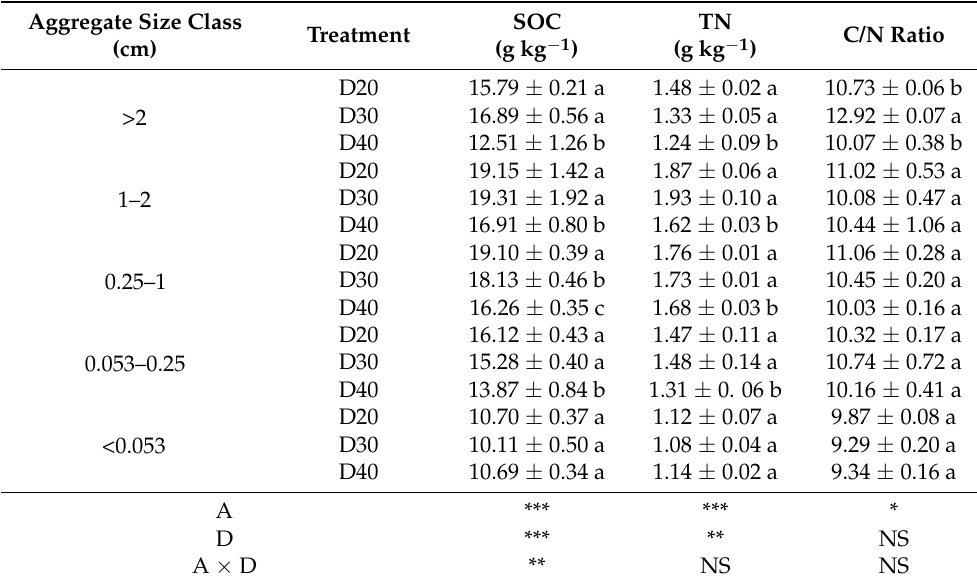
Figure 2. Soil aggregate size distribution and mean weight diameter (MWD). Note: the relative abundance and MWD were different significantly ( p < 0.05). Table 1. Distribution of SOC, TN and C/N ratio according to the aggregate size class under different drip irrigation